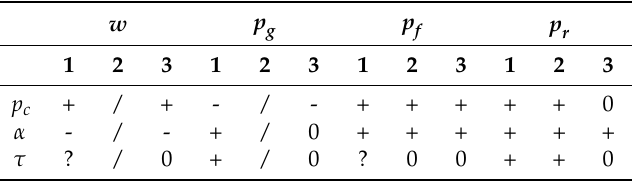
Table 2. The impact of different parameters on the price . 418